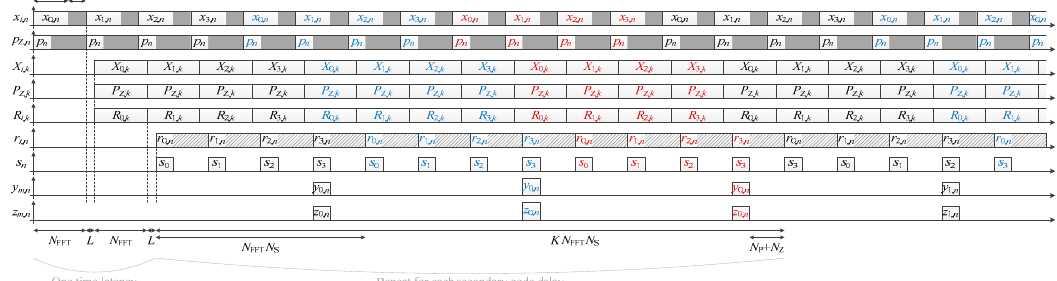
Figure 7. Timing diagram of the pilot channel acquisition shown in Figure 6, with N S = 4 and K = 3 .